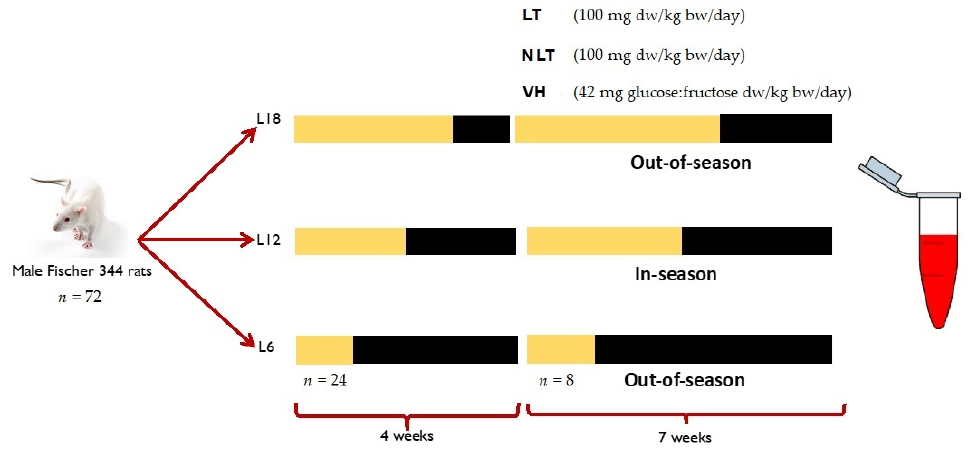
Figure 1. Experimental design of this study. Abbreviations: L18: 18 h light/day; L12: 12 h light/day; L6: 6 h light/day; LT: local tomatoes; NLT: non-local tomatoes; VH: vehicle; dw: dry weight; bw: body weight. The yellow indicates light hours per day of each photoperiod and the black corresponds to darkness hours per day.